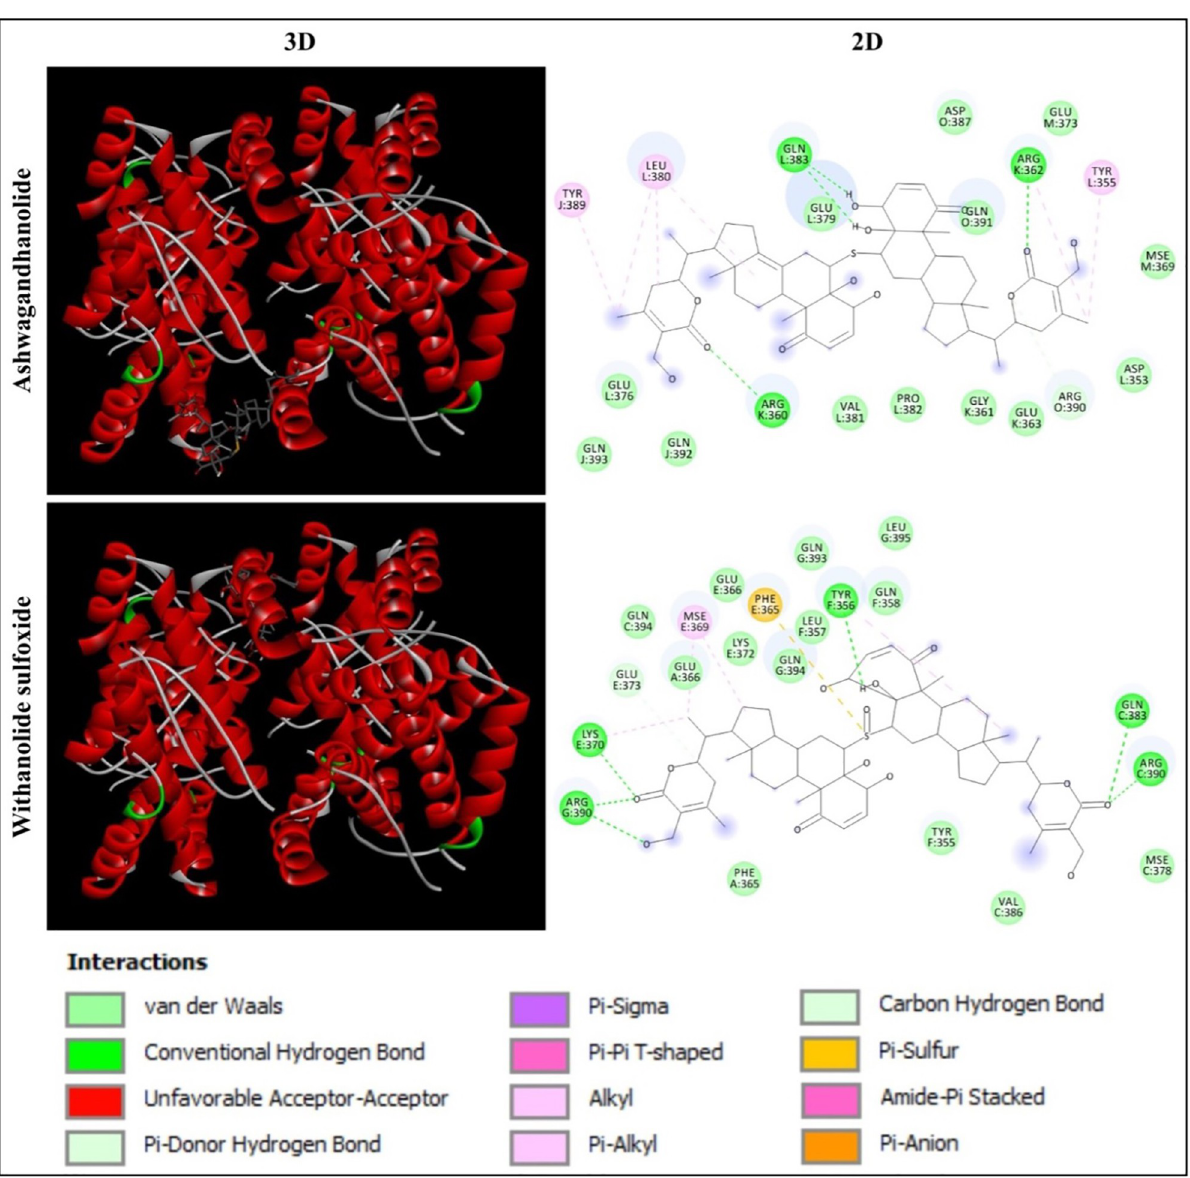
Fig 7. Interaction of human p73 tetramerization domain (PDB: 2WTT) with Ashwagandhanolide and Withanolide Sulfoxide. Three-dimensional (3D) illustration shows the interaction of ligands with human p73 tetramerization domain structure and two-dimensional (2D) diagram displays the interactions of the ligand with the specific amino acid residues in the active site of the